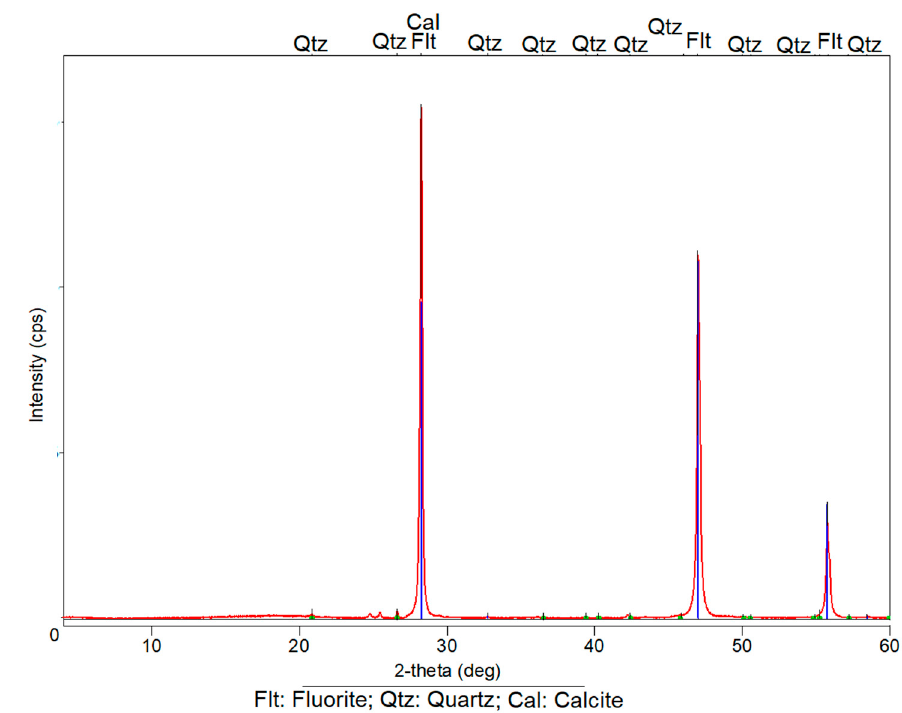
Figure 1. X-ray diffraction patterns of the natural fluorite from the research